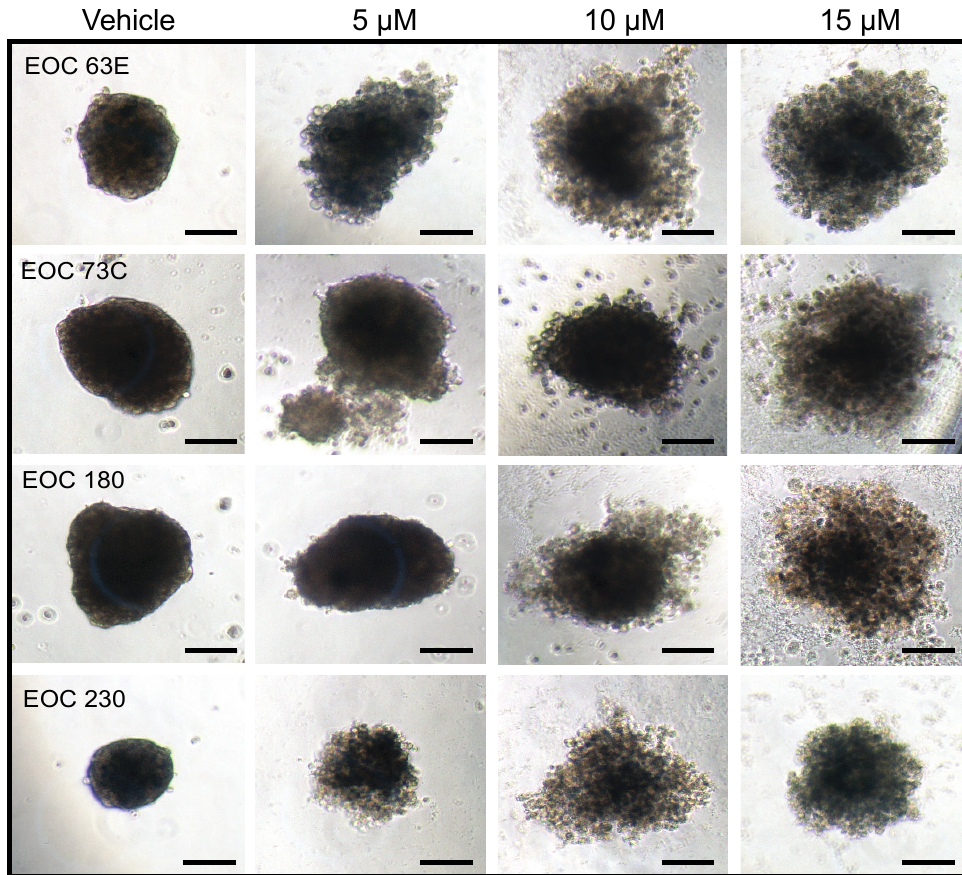
Figure 5. HGSOC cell viability after L -Rham treatment. Alteration in spheroid morphology in response to increasing doses of L -Rham after 48 h. Solid bar = 100 µm. Modified from reference [49], with permission.